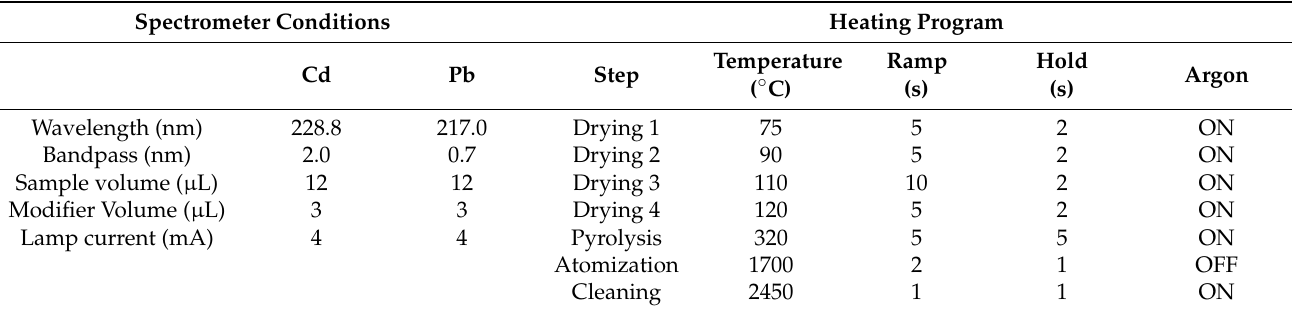
Table 2. Instrumental operating conditions and heating program for the simultaneous determination of Cd and Pb.